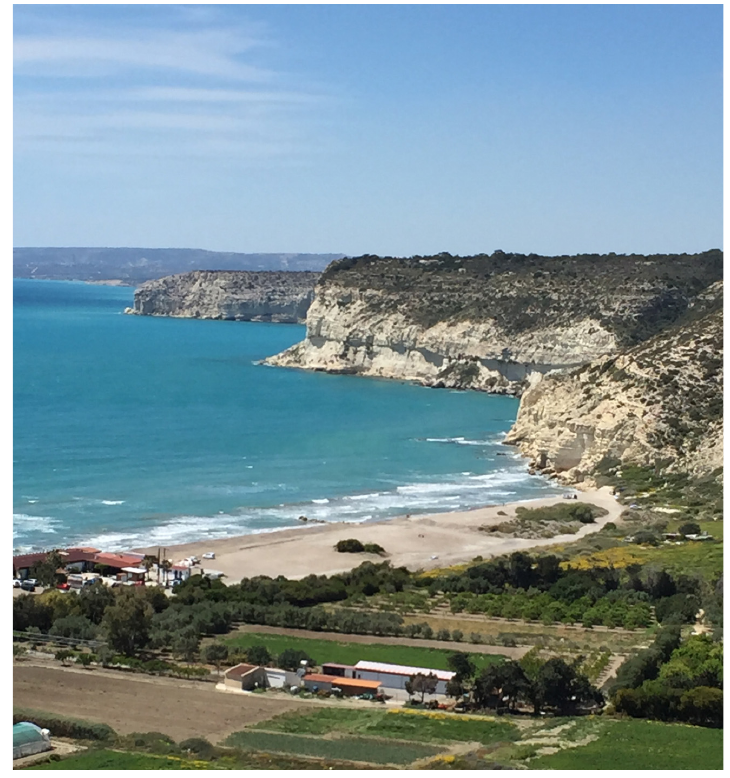
Figure 4. View from Kourion of limestone plateau and cliffs. Photo: L.